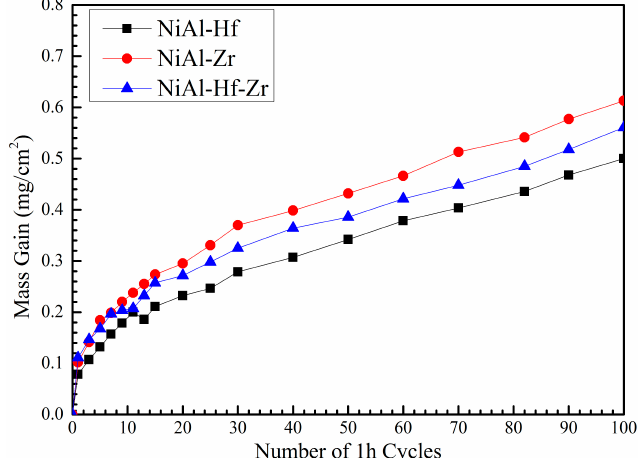
Figure 4. The mass gain of the NiAl–Hf, NiAl–Zr and NiAl–Hf–Zr coatings during 100 h cyclic oxidation at 1150 °C.